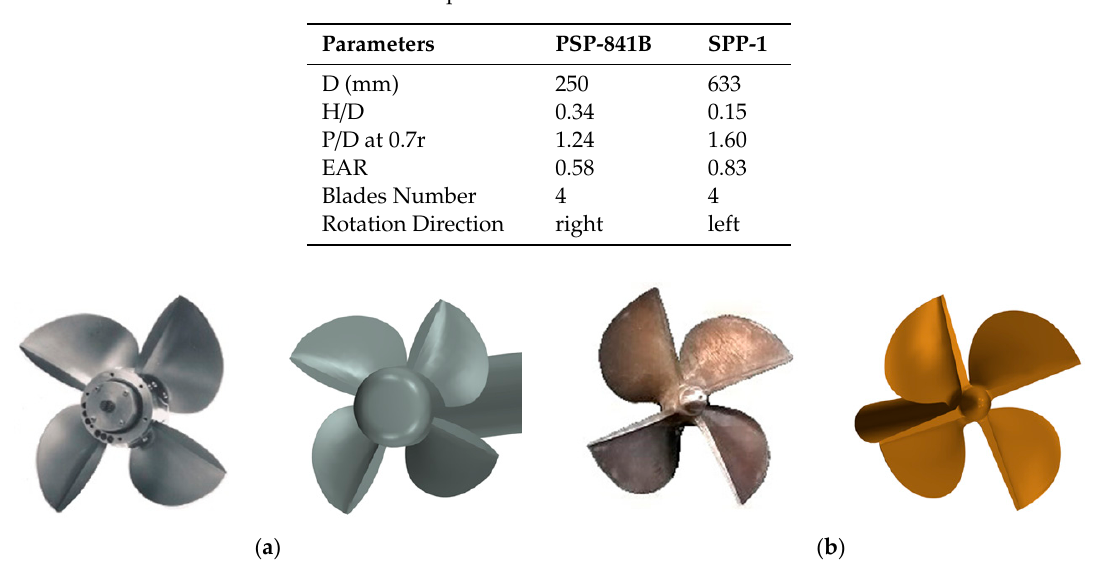
Table 1. Main parameters of PSP-841B and SPP-1.